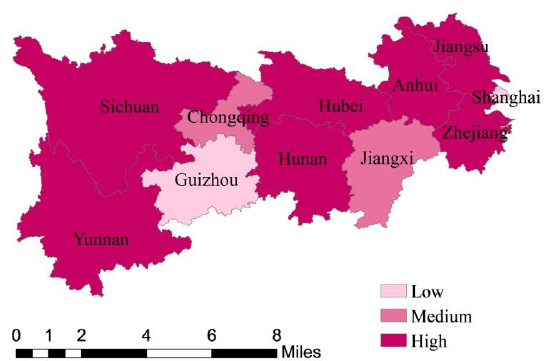
Figure 4. Same as Figure 3, but for the EC (technical efficiency) index.